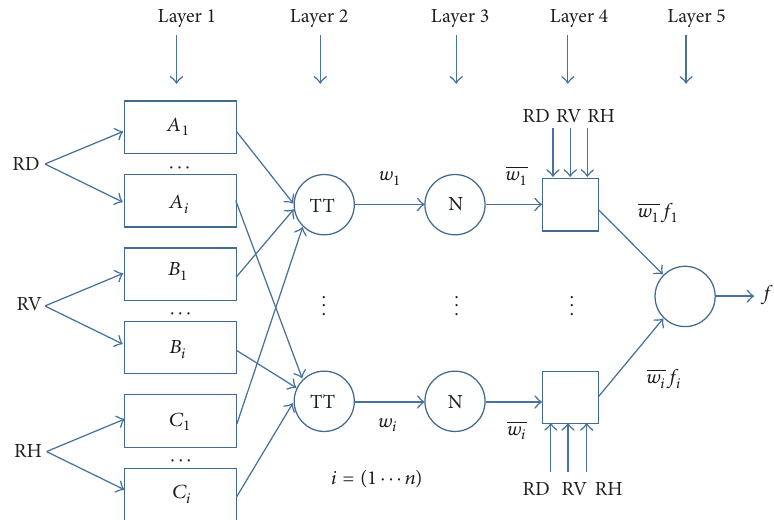
Figure 3: Structure of the ANFIS-based collision avoidance